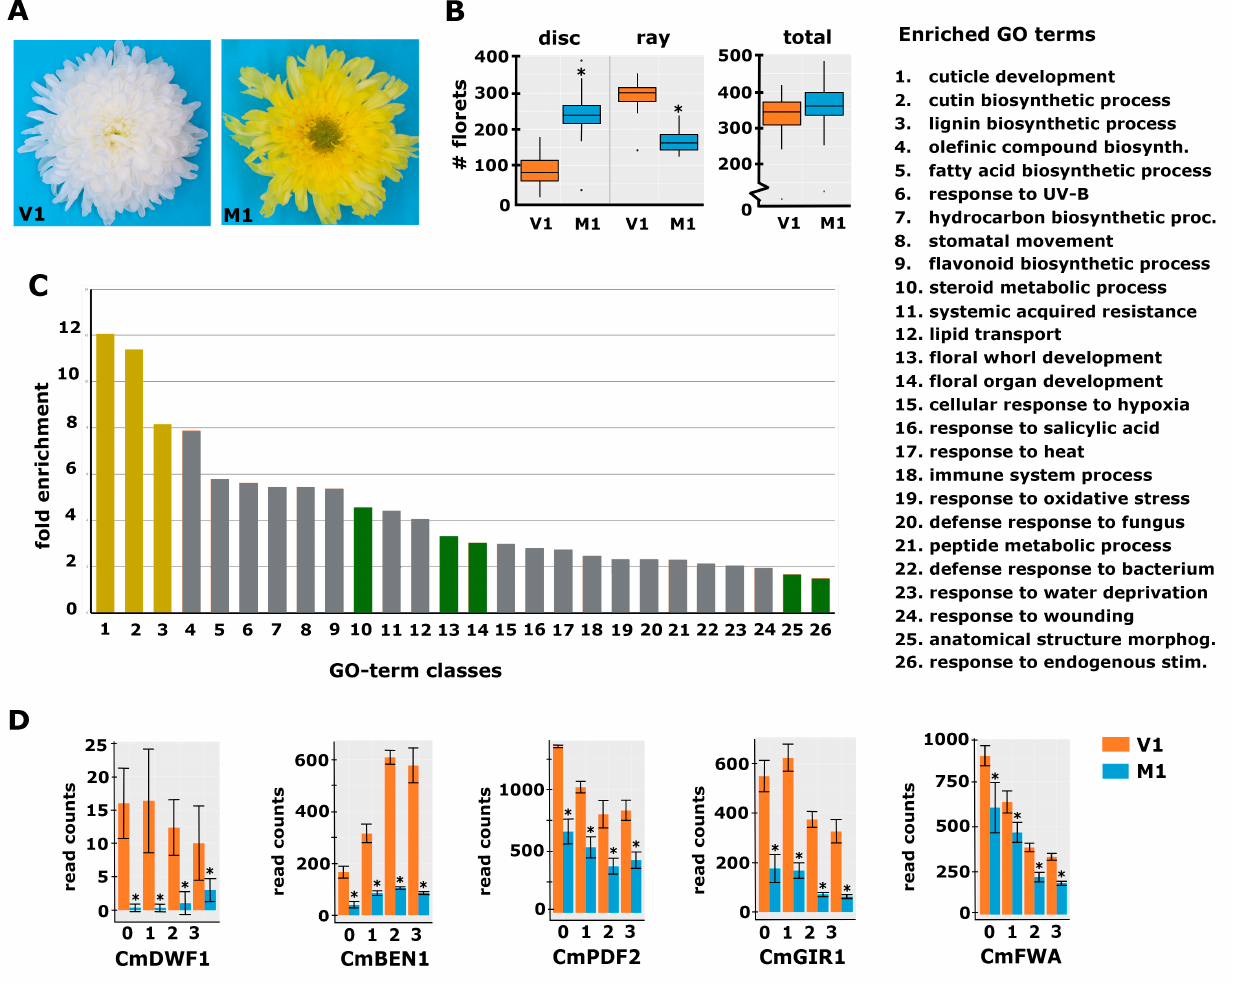
Figure 2. Phenotypic characterization of a spontaneous chrysanthemum mutant with decreased disc:ray floret ratio. ( A ) Top view of a mature capitulum from variety 1 (V1; left) and its spontaneous mutant (M1; right) that showed a strong increase in the number of disc florets and yellow instead of white ligules. ( B ) Boxplot showing the number of disc and ray florets and the total number of florets in V1 and M1 capitula ( n = 7). ( C ) GO-term enrichment analysis with the DEGs of M1 vs. V1 at stages 0 and 1. The legend for the category numbers is displayed on the right. The y -axis displays the fold enrichment of the number of genes in the category compared to the Arabidopsis genome; the x -axis displays the different significantly enriched categories (FDR < 0.05). The categories discussed in the text are displayed in yellow and green. ( D ) Expression plots for five selected genes from the RNA-seq experiment (RPKM read count values are displayed). The transcript identifiers are as follows: CmDWF1 , DN96938; CmBEN1 , DN45086; CmPDF2 , DN65126; CmGIR1 , DN43323; and CmFWA , DN60377. The numbers at the x -axis indicate the stages. Error bars indicate the SE of the three biological replicates; asterisks indicate significance at Padj <